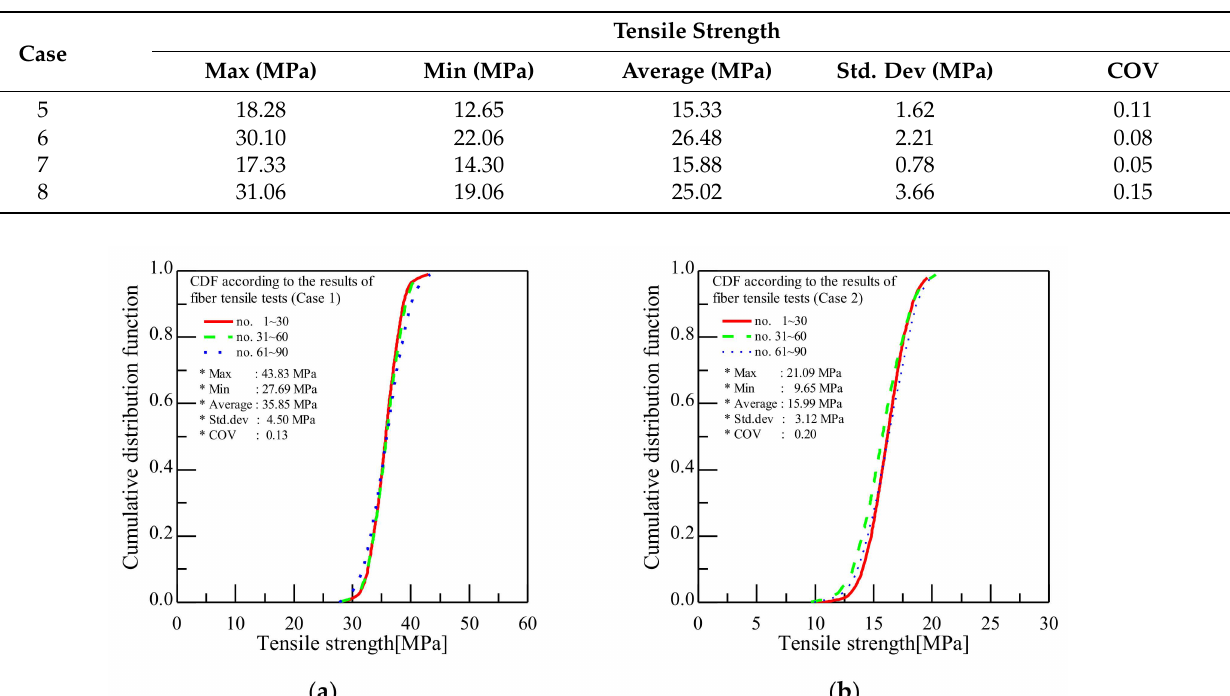
Figure 10. Cumulative distribution functions for tensile strength. ( a ) Case 1 ( x 1 : x 2 : x 3 : x 4 = 40:60:120:200); ( b ) Case 2 ( x 1 : x 2 : x 3 : x 4 = 60:60:120:200).